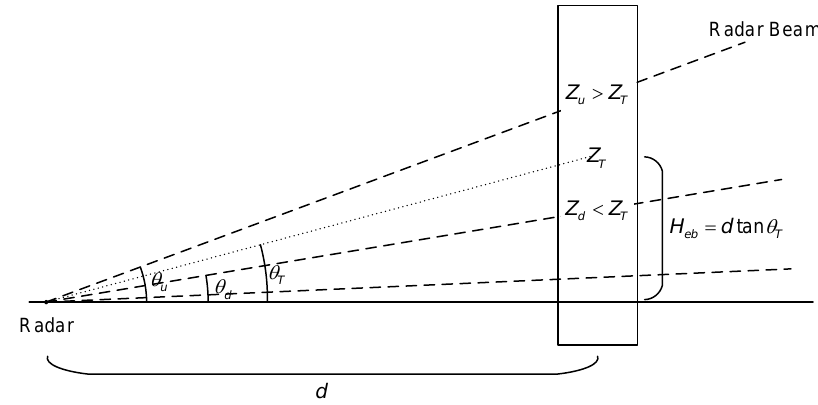
Figure 4. Schematic diagram of estimating Z T dB Z echo bottom height H eb at a